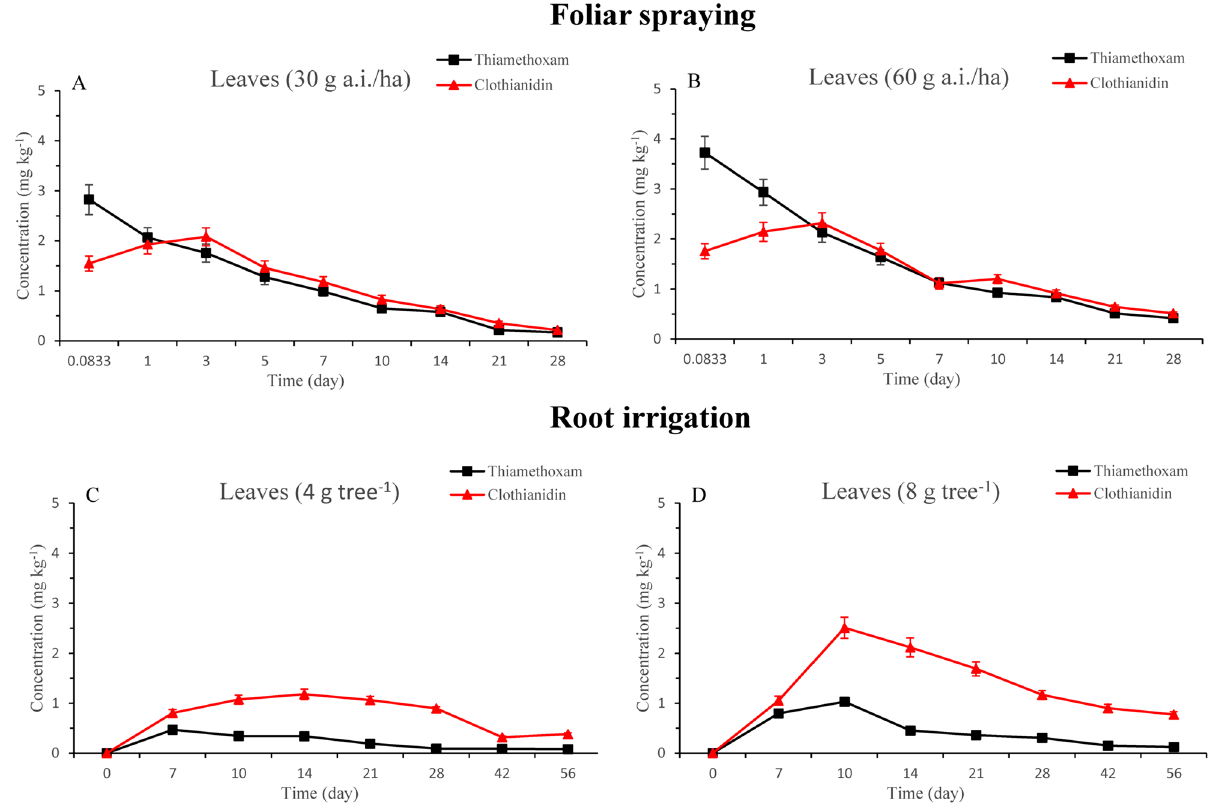
Figure 1. Residues of thiamethoxam and clothianidin in leaves after application by foliar spraying at standard ( A ) and 2 times ( B ) dose treatments and by root irrigation at 4 g tree −1 ( C ) and 8 g tree −1 ( D